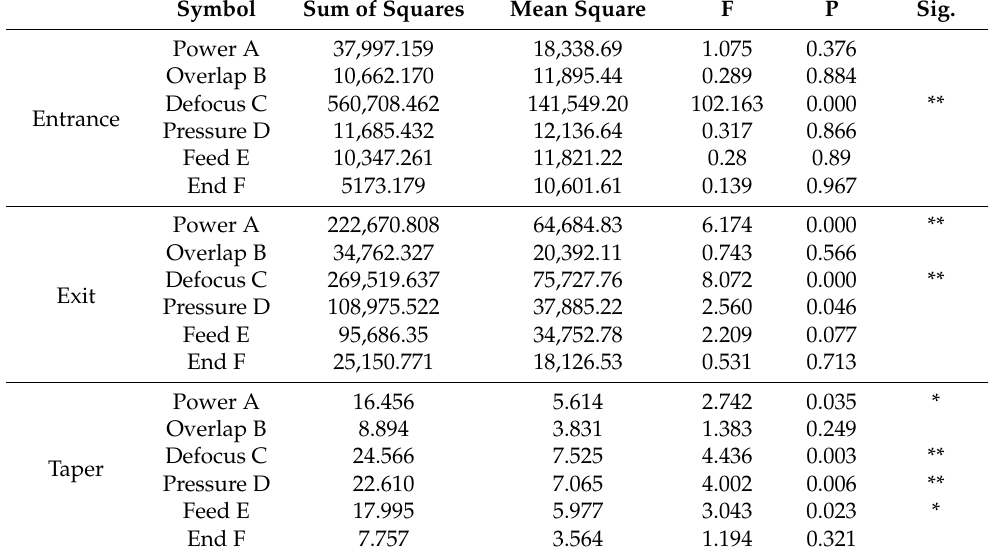
Table 4. ANOVA results for each